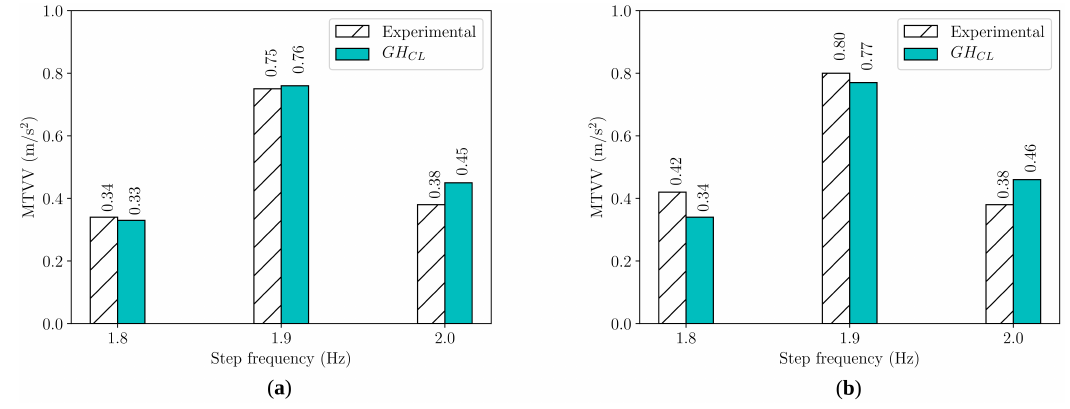
Figure 14. Step frequency variation: ( a ) Test subject 1 ( m h = 71.8 kg). ( b ) Test subject 7 ( m h = 73.4